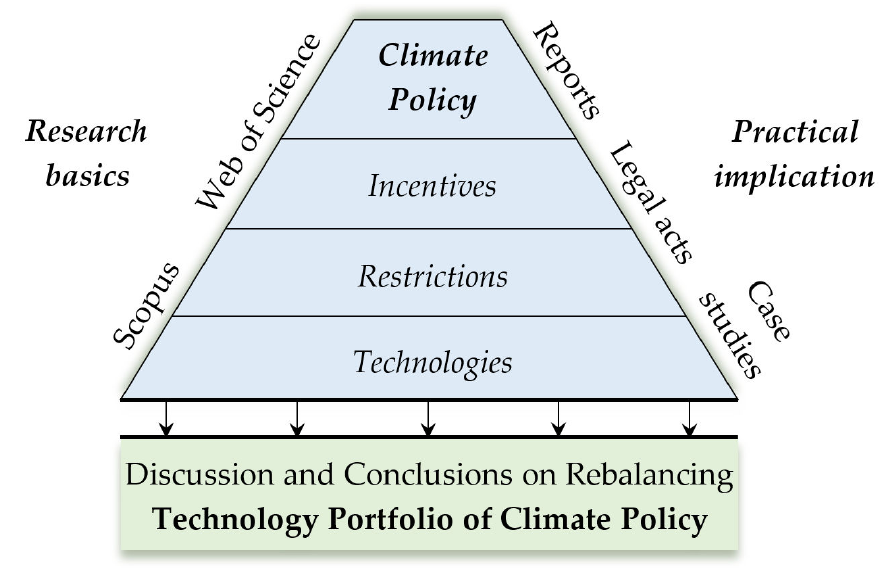
Figure 2. Framework of the